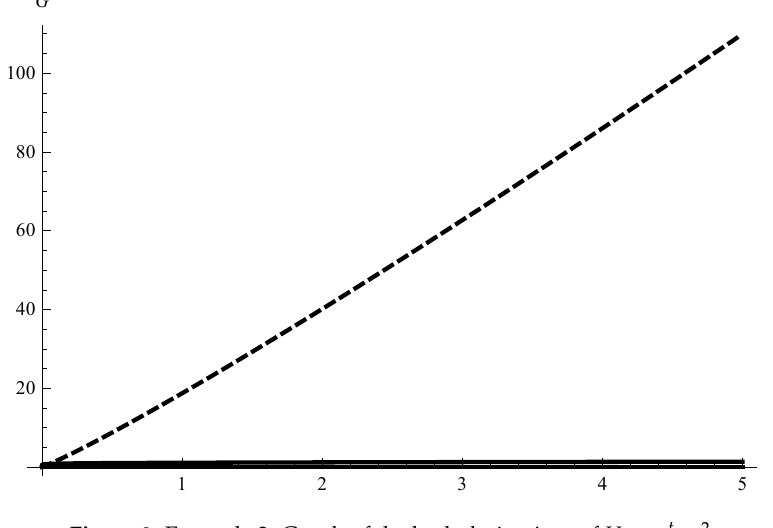
Figure 2. Example 3. Graph of the both derivatives of V = t